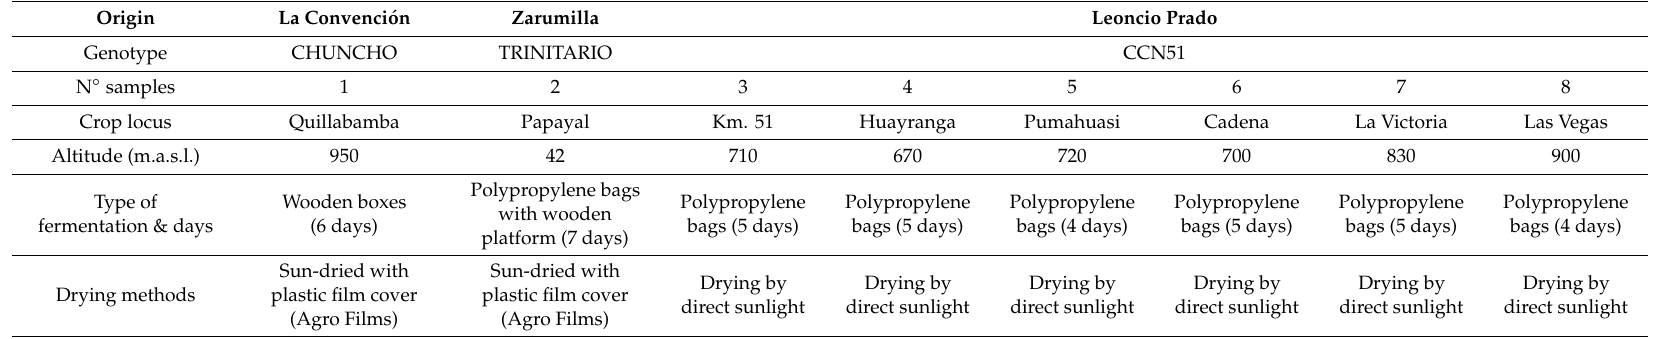
Table 3. Origin, crop, drying types and methods of each genotype of cocoa